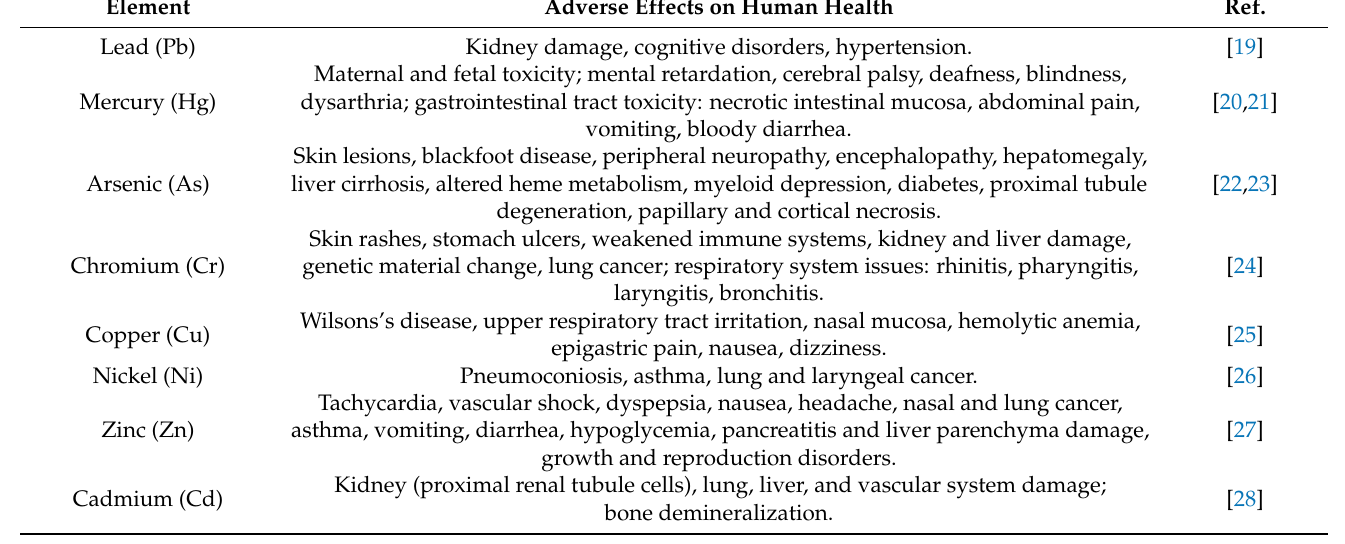
Table 1. Representative toxic heavy metals and their adverse effects on human health. Element Adverse Effects on Human Health Ref. Lead (Pb) Kidney damage, cognitive disorders, hypertension. Maternal and fetal toxicity; mental retardation, cerebral palsy, deafness, blindness, dysarthria; gastrointestinal tract toxicity: necrotic intestinal mucosa, abdominal pain, vomiting, bloody diarrhea. Skin lesions, blackfoot disease, peripheral neuropathy, encephalopathy, hepatomegaly, Arsenic (As) liver cirrhosis, altered heme metabolism, myeloid depression, diabetes, proximal tubule degeneration, papillary and cortical necrosis. Skin rashes, stomach ulcers, weakened immune systems, kidney and liver damage, Chromium (Cr) genetic material change, lung cancer; respiratory system issues: rhinitis, pharyngitis, laryngitis, bronchitis. Wilsons’s disease, upper respiratory tract irritation, nasal mucosa, hemolytic anemia, epigastric pain, nausea, dizziness. Pneumoconiosis, asthma, lung and laryngeal cancer. Tachycardia, vascular shock, dyspepsia, nausea, headache, nasal and lung cancer, asthma, vomiting, diarrhea, hypoglycemia, pancreatitis and liver parenchyma damage, growth and reproduction disorders. Kidney (proximal renal tubule cells), lung, liver, and vascular system damage; bone